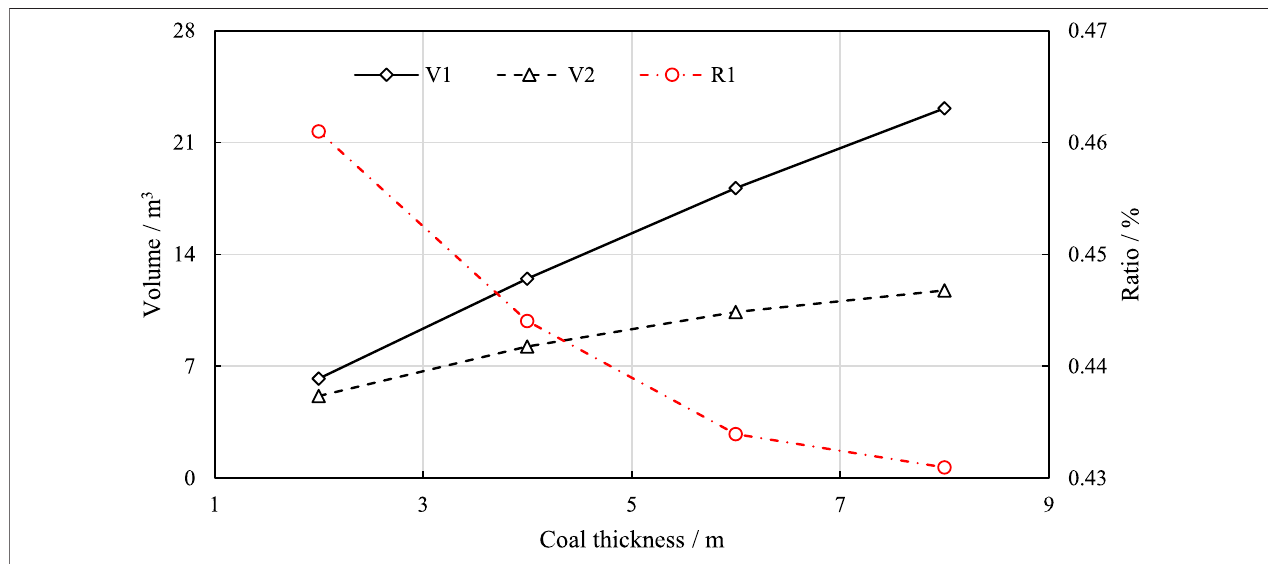
FIGURE 4 | Goaf storage capacity with varying thickness of coal seam. V1 and V2 represent the total volume of goaf reservoir and admissible capacity when the water level is 17.8 m, respectively; R1 is the storage ratio, the ratio of total capacity to the volume of excavated coal.